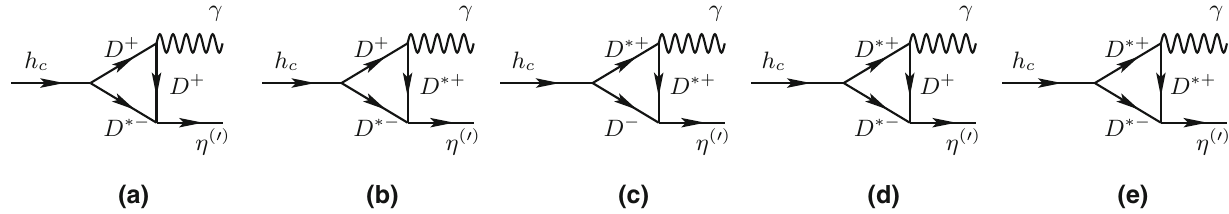
Fig. 1 The hadron-level diagrams for h c → γη and γη (cid:3) via charged intermediate charmed meson loops. Similar diagrams for neutral and strange intermediate charmed meson